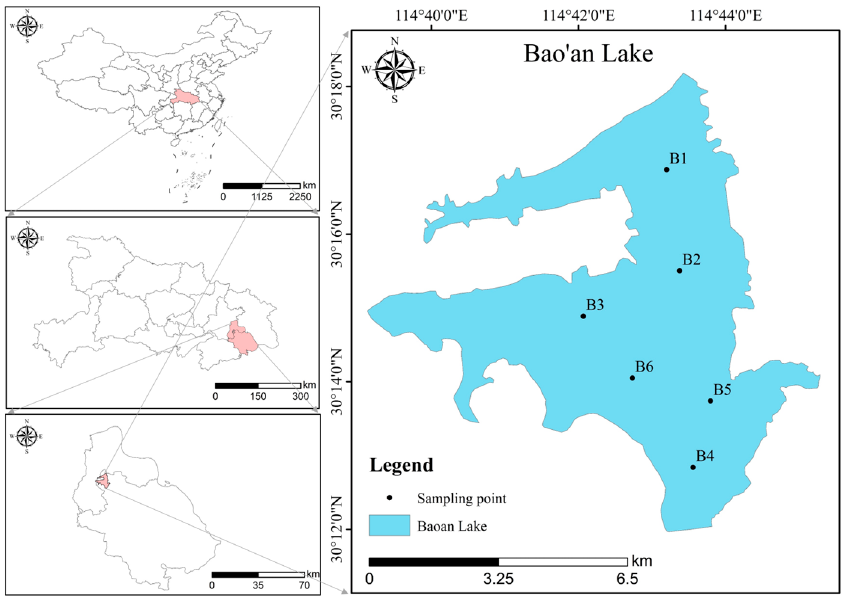
Figure 1. Distribution of sampling sites in Bao’an Lake.